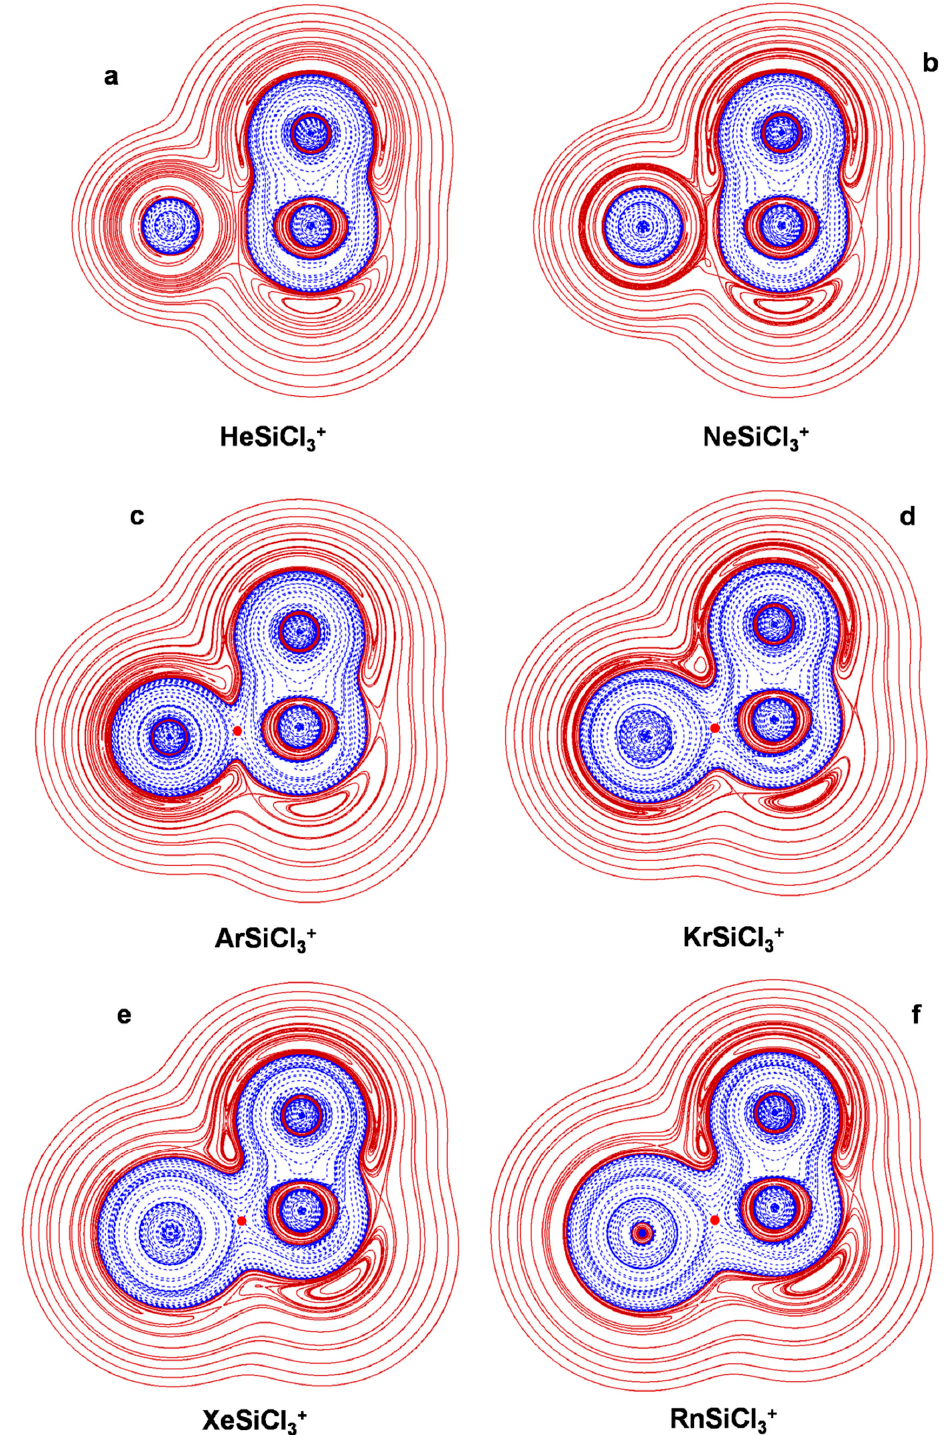
Figure 4. 2D plots of H ( r ) in the symmetry plane of ( a ) HeSiCl 3+ ; ( b ) NeSiCl 3+ ; ( c ) ArSiCl 3+ ; ( d ) KrSiCl 3+ ; ( e ) XeSiCl 3+ ; ( f ) RnSiCl 3+ (solid/brown and dashed/blue lines correspond, respectively, to positive and negative values). The red dots represent the HCPs.